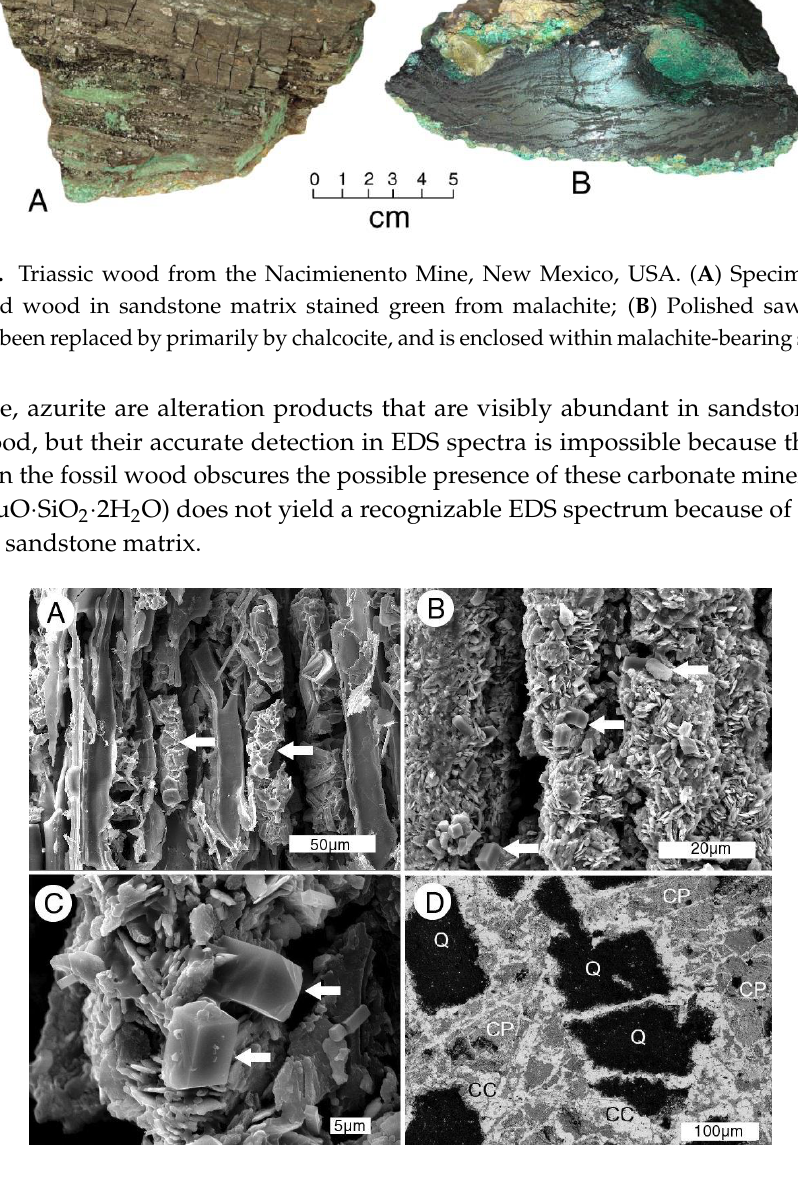
Figure 17. SEM images of iron mineralized wood from the Naciemento Mine. ( A ) Carbonized cell walls and cell lumina contain marcasite (arrows); ( B ) cells mineralized with tabular crystals of hematite, with small prismatic aragonite crystals (arrows); ( C ) high magnification view showing bipyramidal orthorhombic aragonite crystals on hematite (arrows); ( D ) back-scattered electron image of cut surface of wood replaced by minerals. Q = quartz sand grains from the fossil matrix are enclosed within a complex matrix of chalcopyrite (CP) and chalcocite (CC).